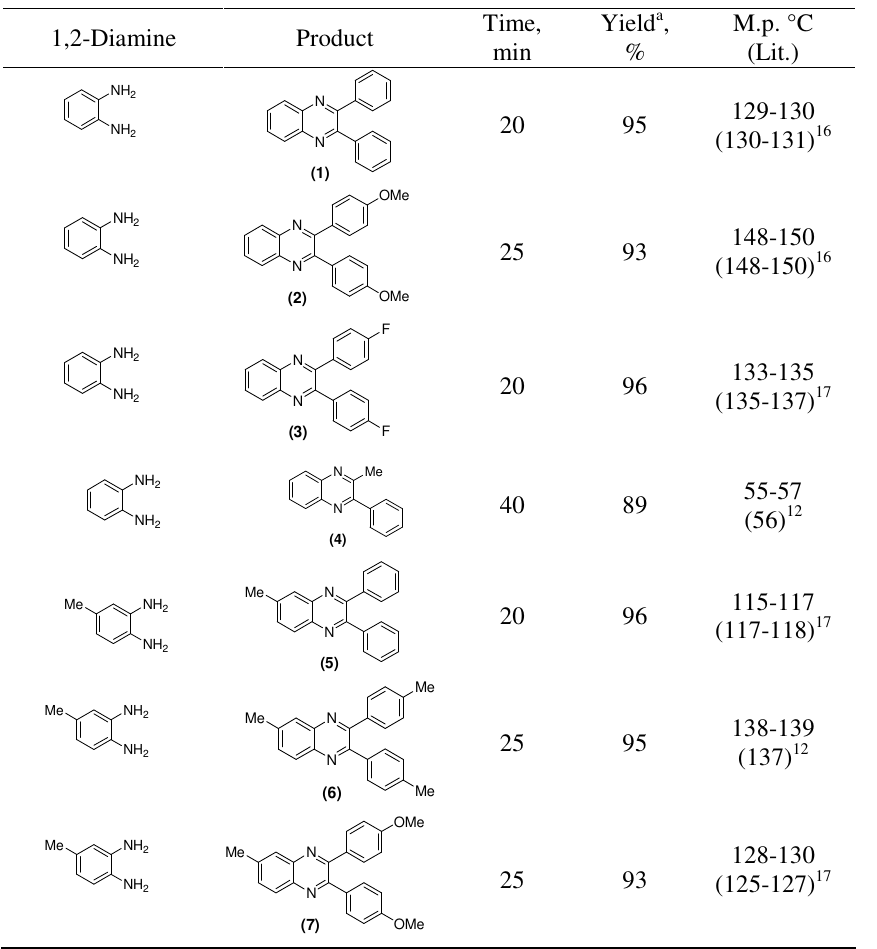
Table 3. Synthesis of quinoxalines via the condensation of 1,2-diamines with α -diketones using bentonite clay K-10 at room